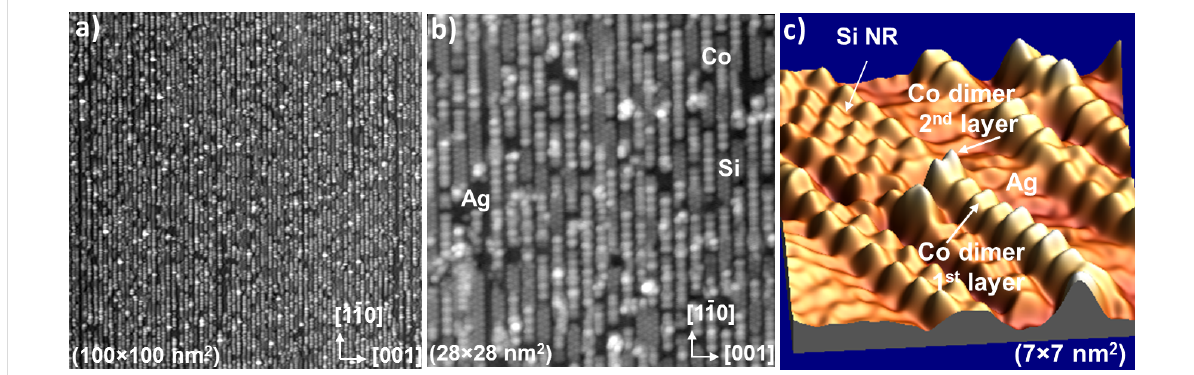
Figure 2: (a,b) STM images at different magnification scales, recorded at 77 K for a Co coverage of approx. 0.6 monolayers, showing the formation of identical and highly ordered Co dimer nanolines on the Si nanoribbon array grown on Ag(110) after Co deposition at 220 K. I = 90 pA, V sample = − 1 V. (c) High-resolution STM image of a Co dimer nanoline grown at RT on a Si nanoribbon (NR). I = 1.3 nA, V sample = 0.55 V.